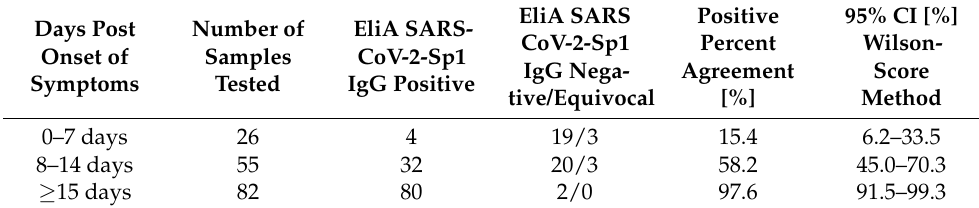
Table 1. Positive Percent Agreement